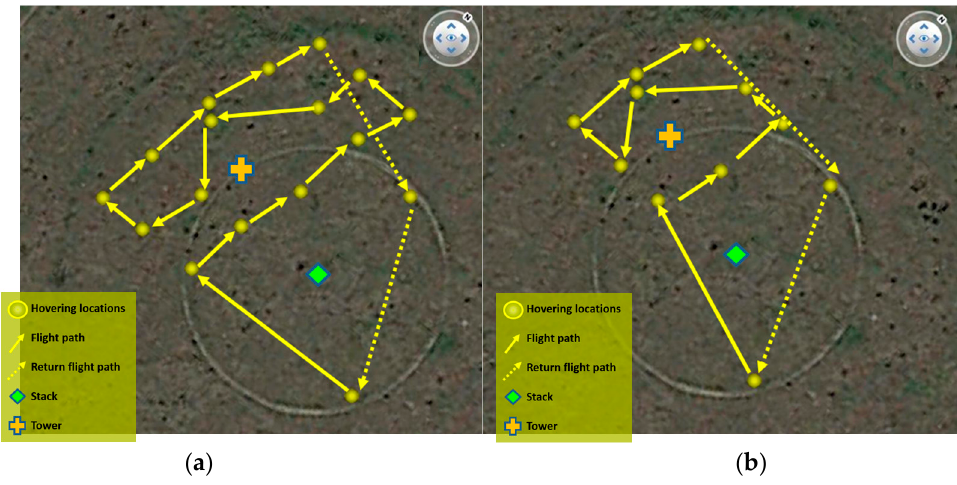
Figure 14. Characterizing zig-zag grids designed for ( a ) Test 1 and ( b ) Test 2.